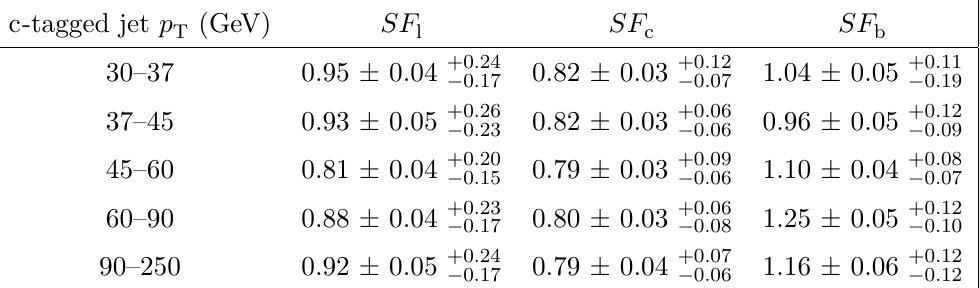
, Z + c jet SF , and Z + b jet SF scale factors measured in the l c b . The first uncertainty is the statistical uncertainty T